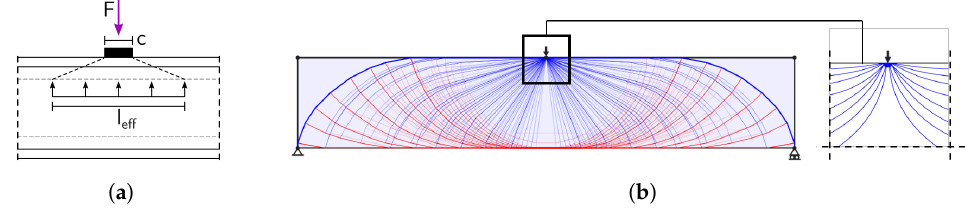
Figure 9. ( a ) Effective load propagation length based on [24]; ( b ) Principle stress lines of a beam with concentrated load; visuals obtained using LayOpt [27] with attention on the disturbed region, covered in